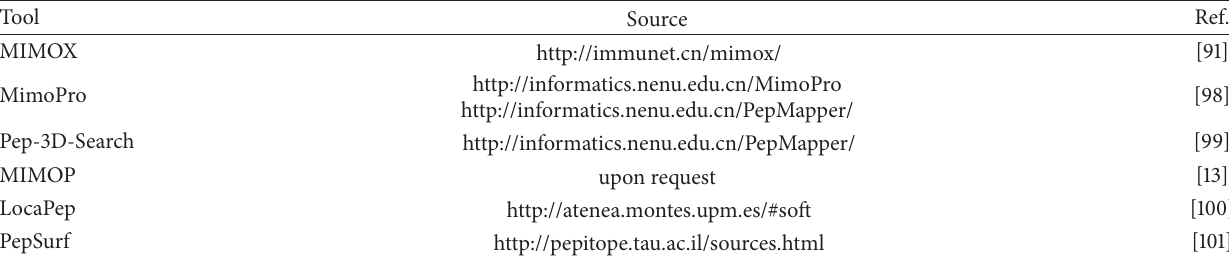
Table 4: List of B-cell epitope prediction tools based on mimotope